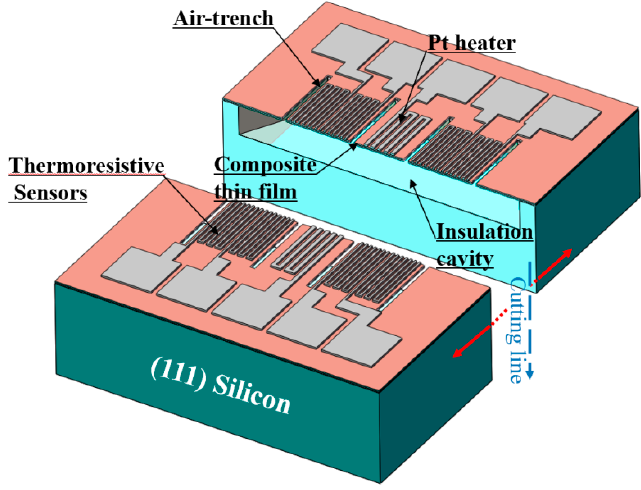
Figure 1. Three-dimensional schematic of the type B gas flow sensor on a single (111)